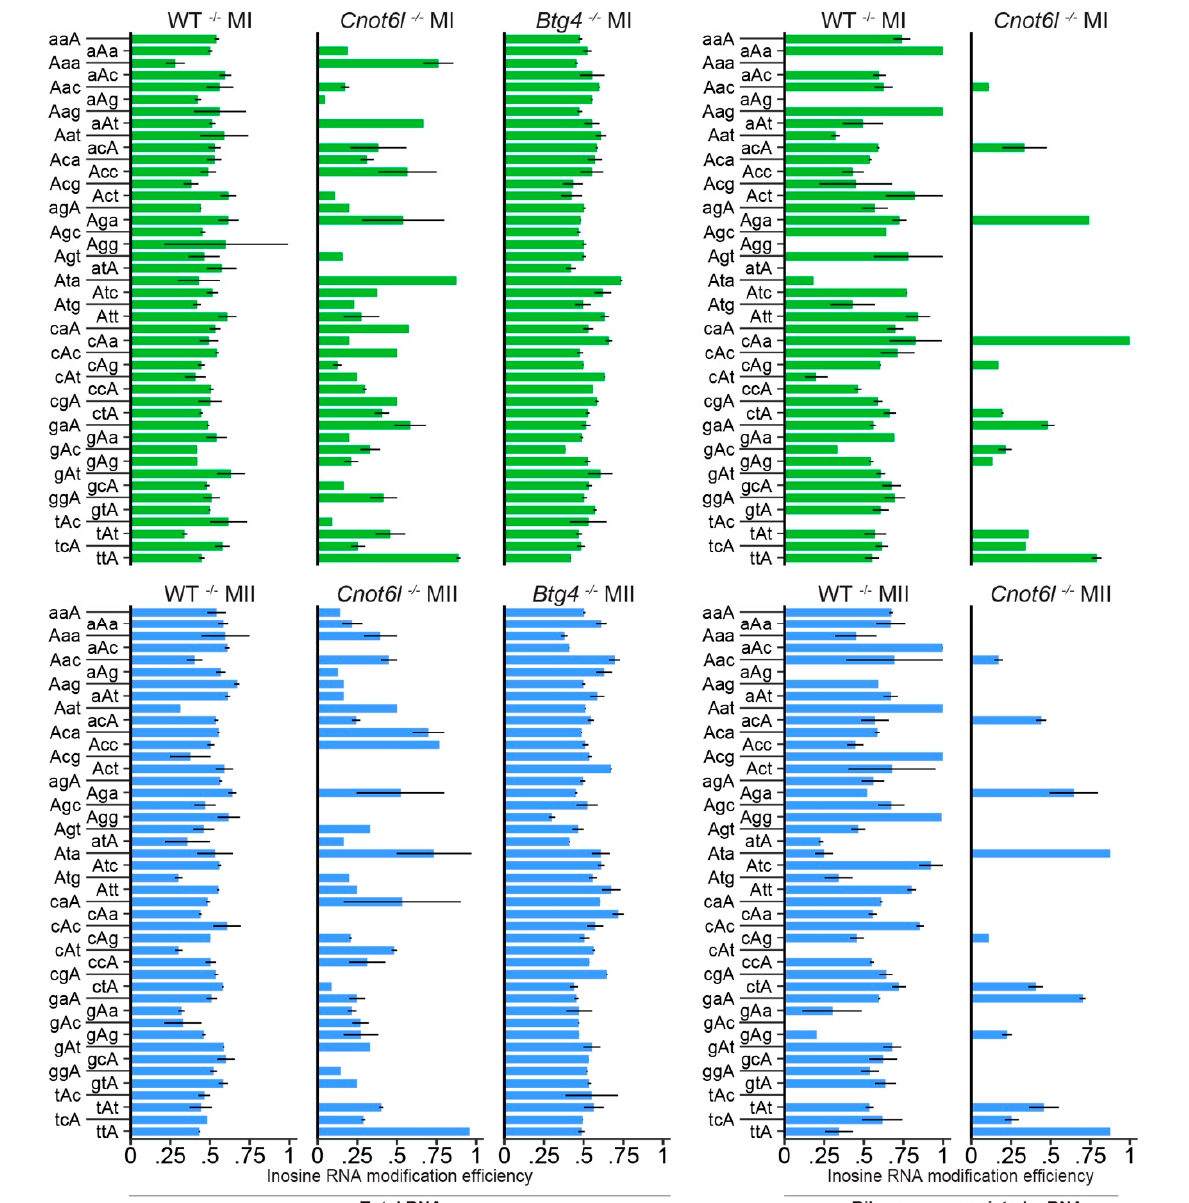
Figure 6. Inosine RNA modification efficiency of total and ribosome-associated mRNA. ( A ) Inosine RNA modification efficiency in total RNA from WT, Cnot6l -/- , and Btg4 -/- oocytes, eggs. ( B ) Inosine RNA modification efficiency in ribosome- associated mRNA from WT and Cnot6l -/- oocytes, eggs. Capital letter denotes the position of the codon with an inosine RNA modification in both panels. Oocyte and egg stages are represented by red bars (GV), green bars (MI), and blue bars